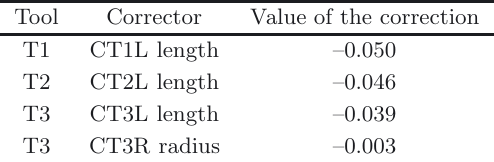
Table 4. Proposed